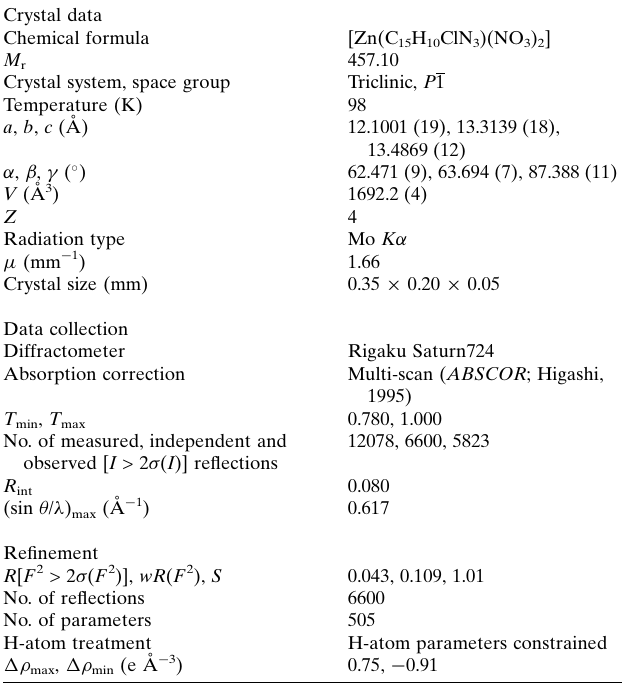
Table 1 Selected geometric parameters (A˚ , (cid:4) ).